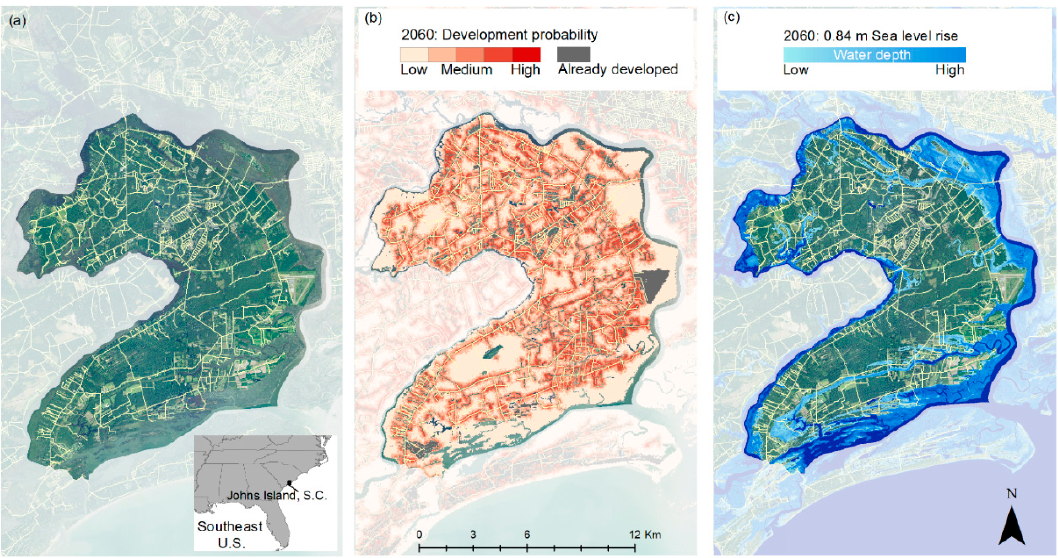
Figure 2. ( a ) Johns Island is located in the Lowcountry of coastal South Carolina. ( b ) Rapid population growth and development is projected to lead to a loss of farmland, forest, and wetlands. ( c ) Projected sea level rise is expected to exacerbate development pressure and conflict over land use.